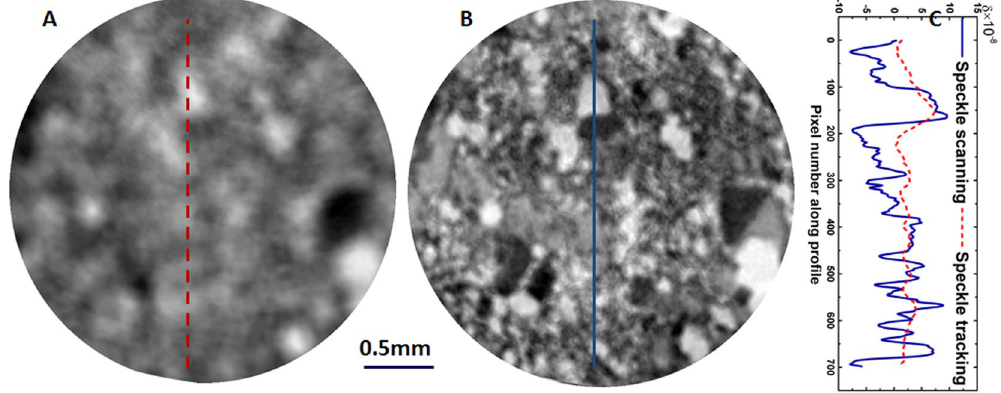
Figure 3. Reconstructed phase contrast axial slices from tomographic reconstruction of volcanic rock sample using ( A ) single-shot speckle tracking and ( B ) multi-frame speckle scanning technique. ( C ) Line profile of the retrieved refractive index decrement. The scale bar at the bottom is 0.5 mm